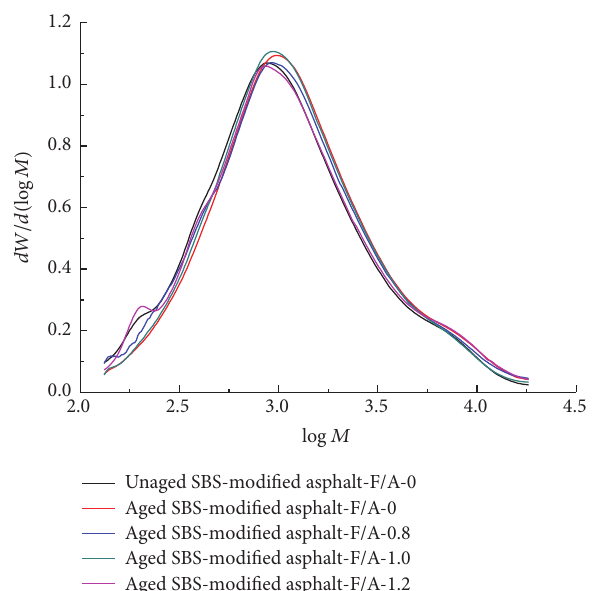
Figure 5: The molecular weight distribution of base asphalt in modified asphalt mortar.